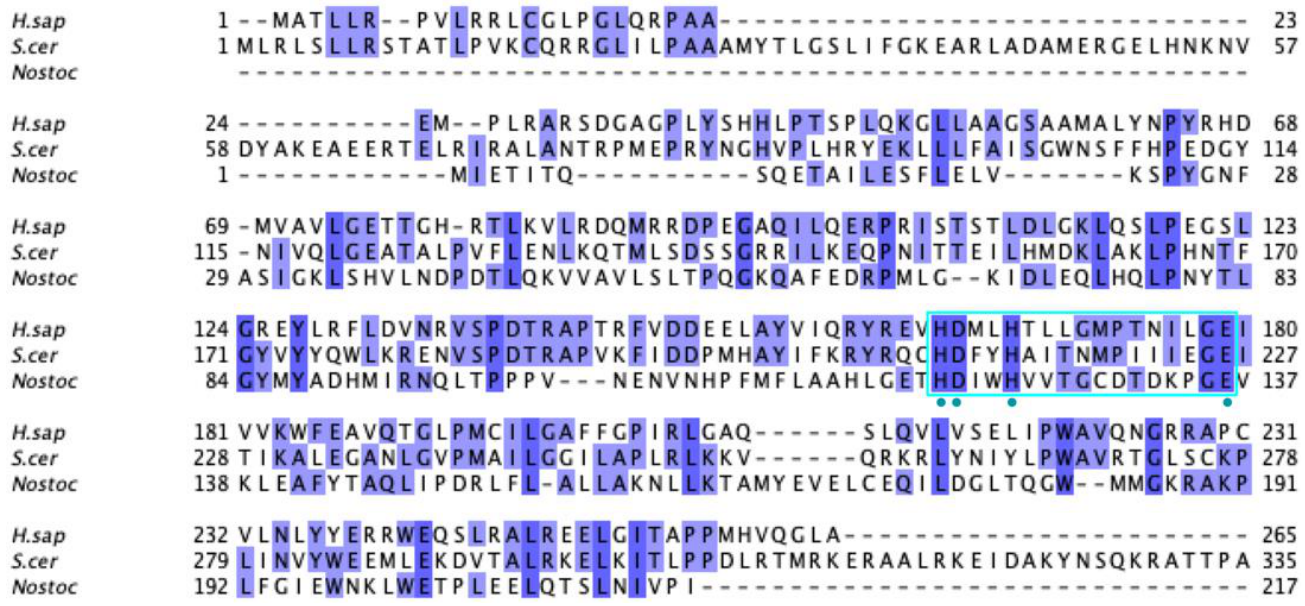
Figure A1. Structural alignment of the human COQ3 model (shown in dark green) and the crystal structure of E. coli UbiG, apo form (shown in pink, PDB: 4KDC). Residues 1 – 90 and 337 – 369 of the AlphaFold model were omitted due to disordered structure. Alignment was performed using PyMOL.